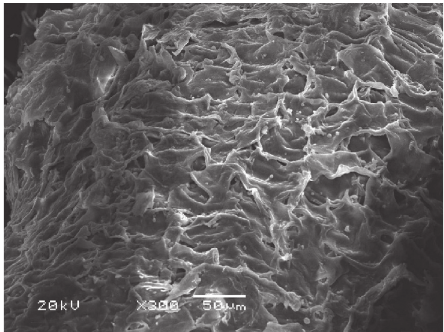
Figure 1: SEM characterization of original rice wine